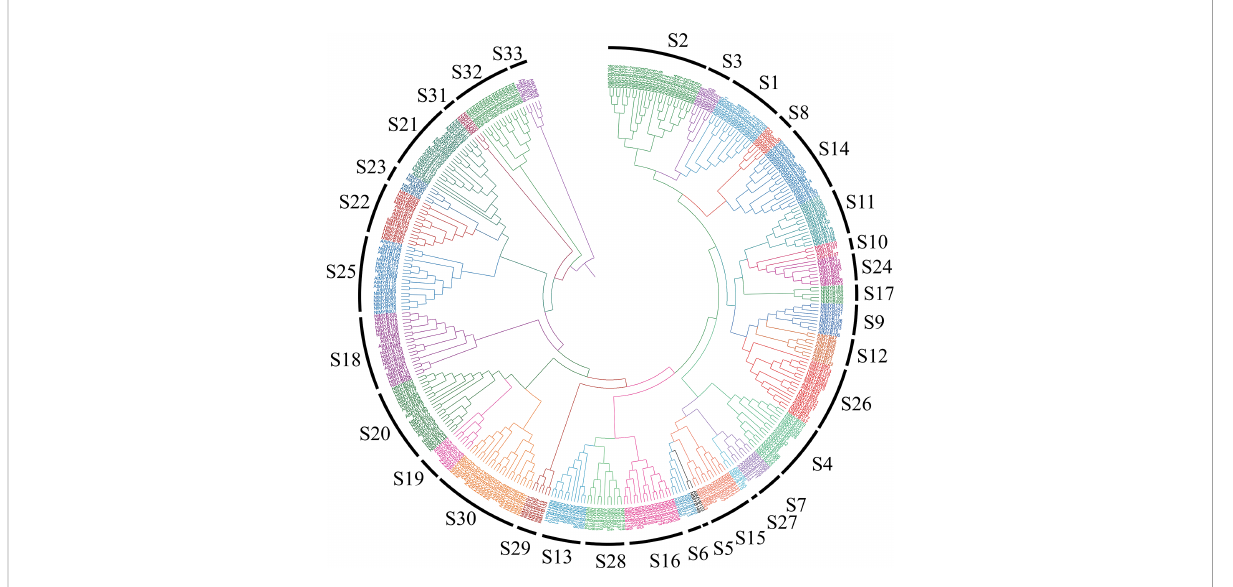
FIGURE 1 Phylogenetic analysis of tobacco R2R3-MYB family members. The tobacco R2R3-MYB members together with their Arabidopsis homologs were classi fi ed into 33